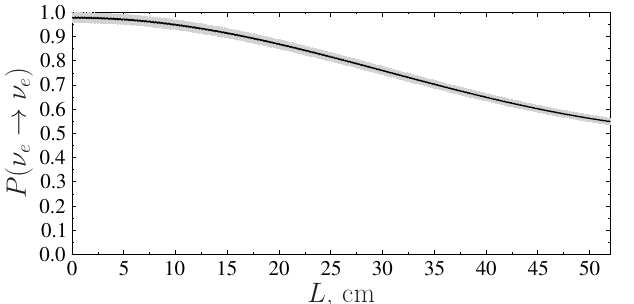
Figure 4. The survival probabilities for ν e depending on the distance L from the neutrino source with parameter values η 2 = 15 ◦ and (cid:101) = 0.087 for the conditions of the Baksan Experiment on Sterile Transitions (BEST)